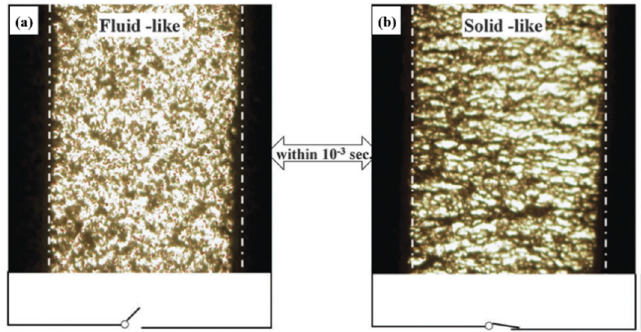
Figure 8. Optical microscopy images of GO / TiO 2 -based ER fluid in the absence of an electric field ( a ) and under an applied electric field ( b ) [53].